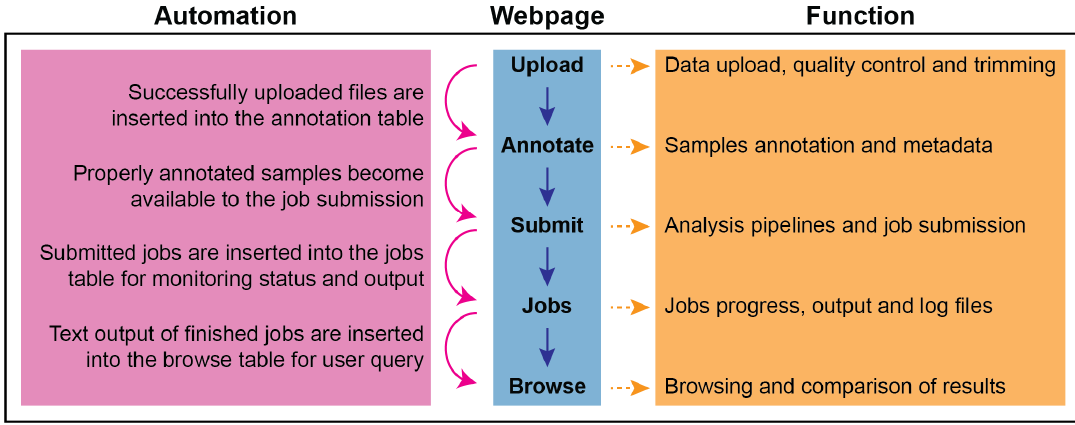
Figure 1. Website Framework of CSI NGS Portal. The middle panel shows the logical flow of the website from top to the bottom, whereas the automated steps of the data transitions from one page to another are described in the left panel, and the function of each page expecting user input/action is given in the right panel.